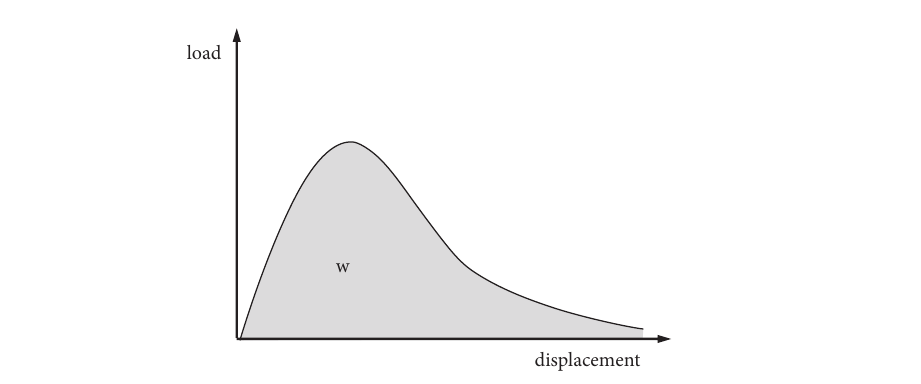
Figure 2: Calculation of the fracture energy.